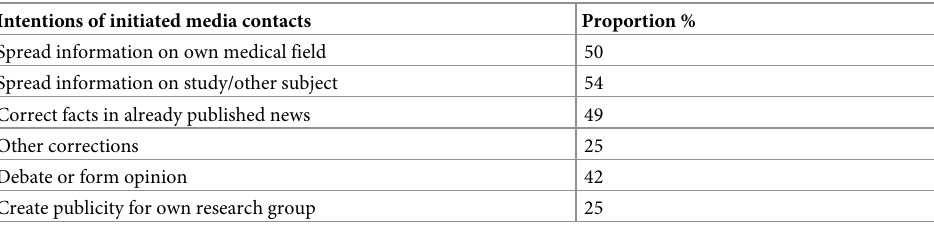
Table 5. Intentions of media